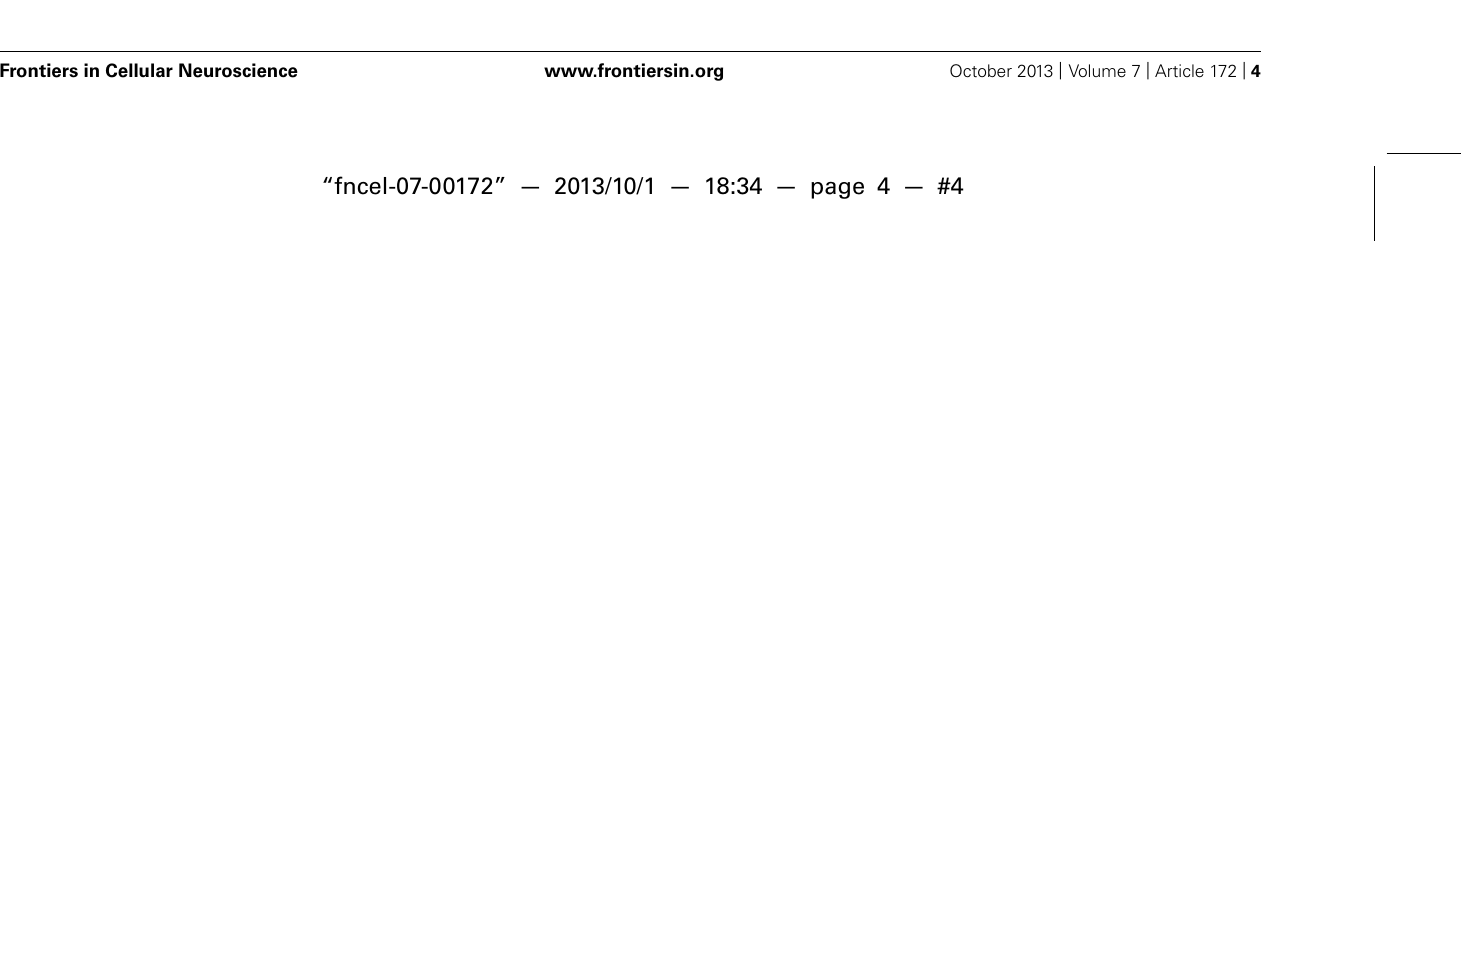
FIGURE 1 | MicroRNAs involved in the regulation of cerebral cortex development . The figure demonstrates microRNAs that have been associated with the three main phases of cortical development. In the first stage, stem cells generate progenitors that are not yet committed to differentiation and can produce neurons, astrocytes, and oligoden- drocytes; the concomitant steps of proliferation and differentiation (5th– 20th weeks of gestation) are regulated by a set of microRNAs: miR-9,